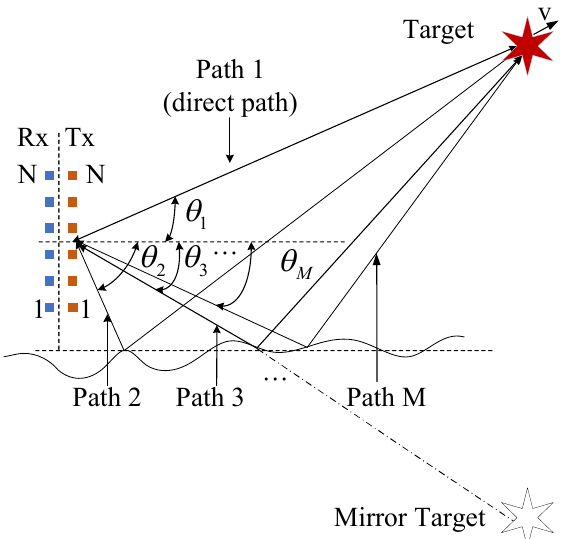
Figure 1. Schematic diagram of time reversal multiple-input multiple-output (TR MIMO) radar multipath